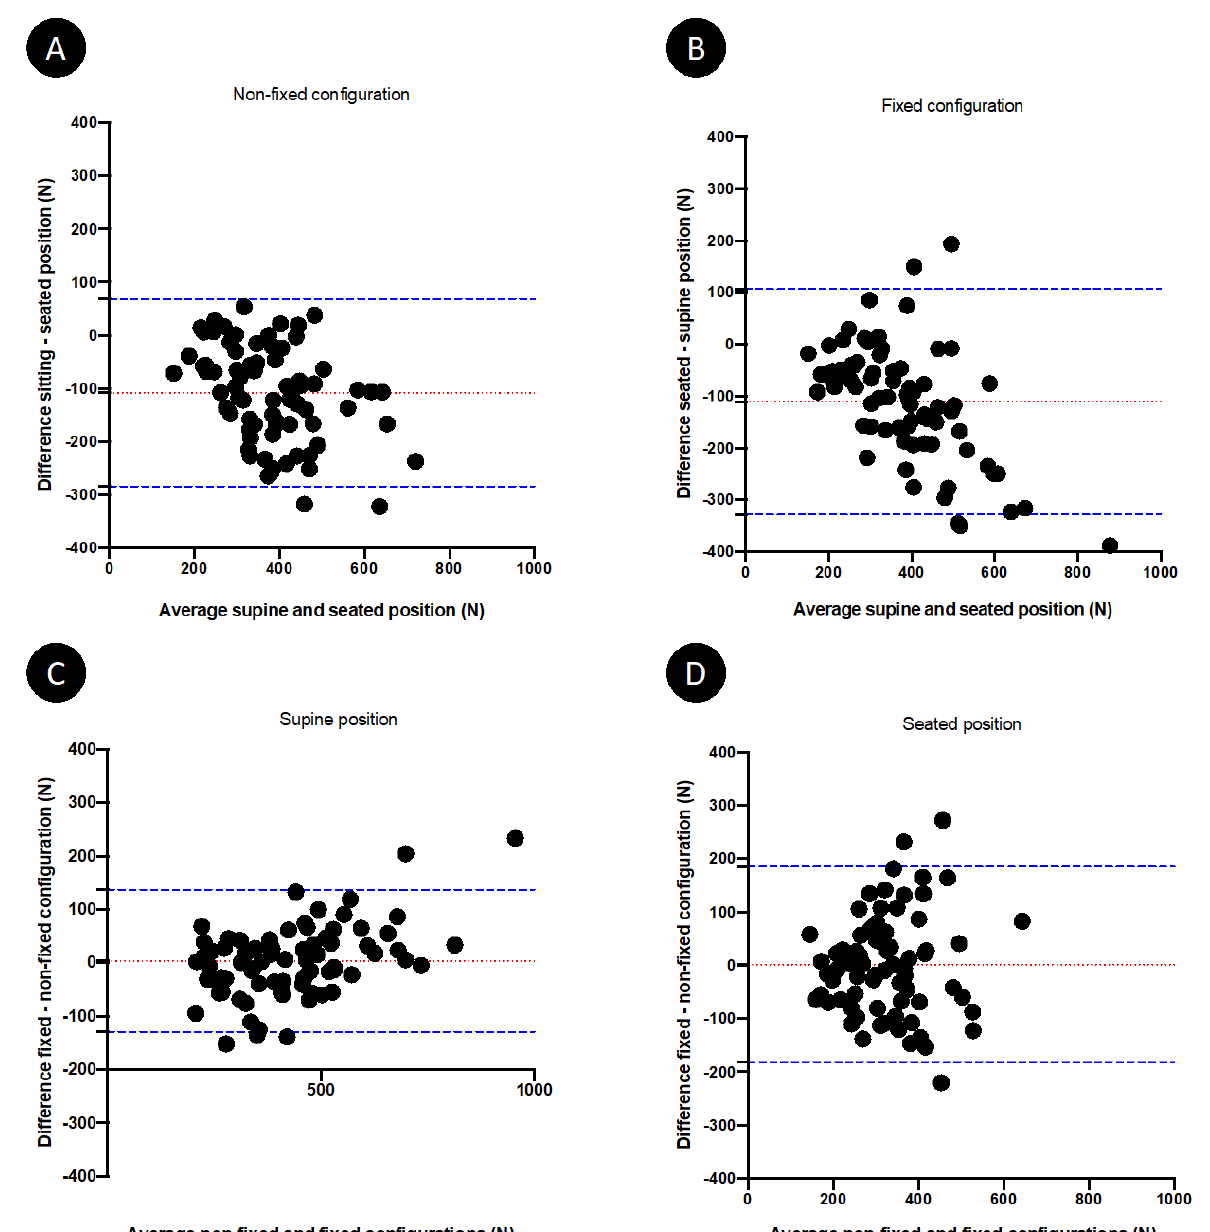
Figure 4. Bland–Altman plots showing the difference between quadriceps strength in the seated (H90-K90) and in the supine (H45-K40) position as the comparison method, in non-fixed ( A ) and fixed ( B ) configuration, and the difference between quadriceps strength in fixed configuration and in non-fixed configuration as the comparison method, in the supine (H45-K40) ( C ) and the seated (H90-K90) ( D ) position.